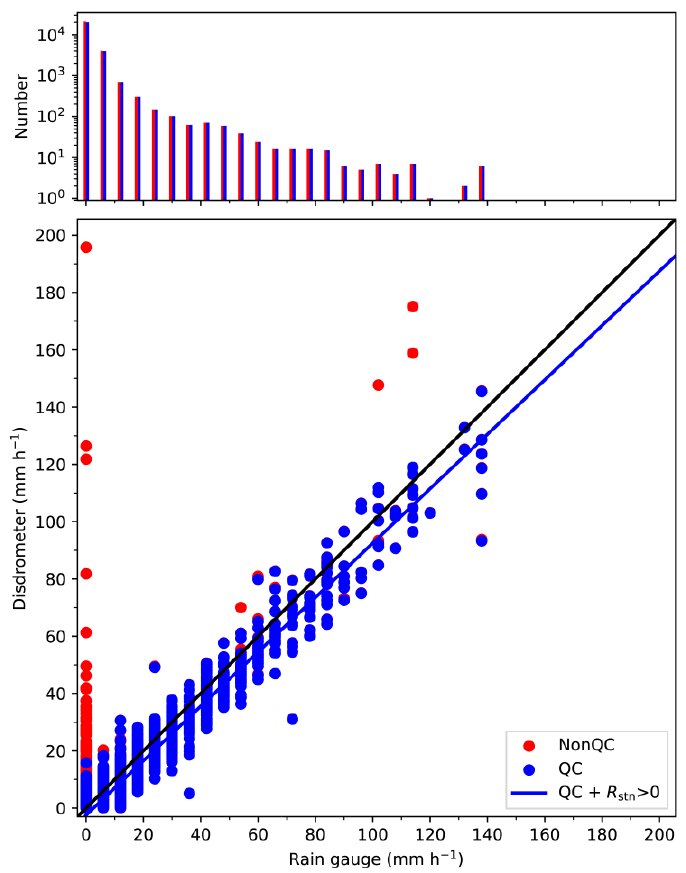
Figure 2. Histogram (top) of the number of 1-min raindrop spectra coinciding with rain gauge measurements ( R stn ); and scatterplot (bottom) of rain rate calculated by PARSIVEL 2 disdrometer measurements vs R stn observations from rain gauge at BJ during the experiment period. The solid black line in the scatterplot is the 1:1 line. Data before (NonQC) and after (QC) quality control are indicated by red and blue dots,